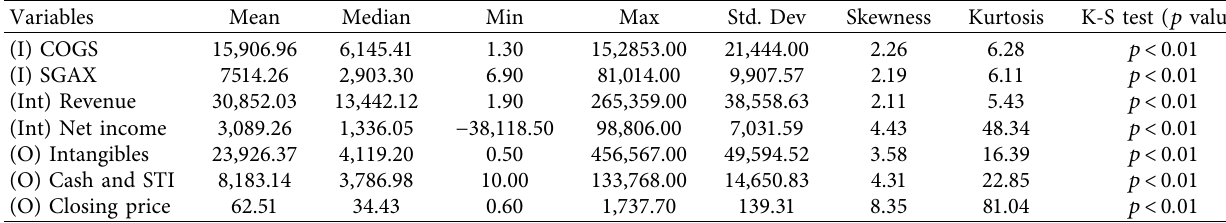
Table 2: Description statistics of variables (unit: USD million).